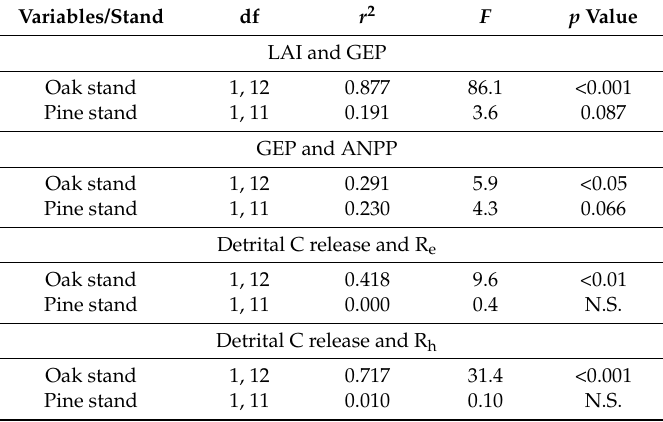
Table 2. Relationships between eddy covariance and biometric measurements at the oak and pine stands. Values are degrees of freedom, linear regression coefficients, F statistics for analysis of variance (ANOVA), and probabilities. LAI: leaf area index; GEP: gross ecosystem production; ANPP: aboveground net primary production; C: carbon; R e : ecosystem respiration; R h : heterotrophic respiration; N.S.: non-significant